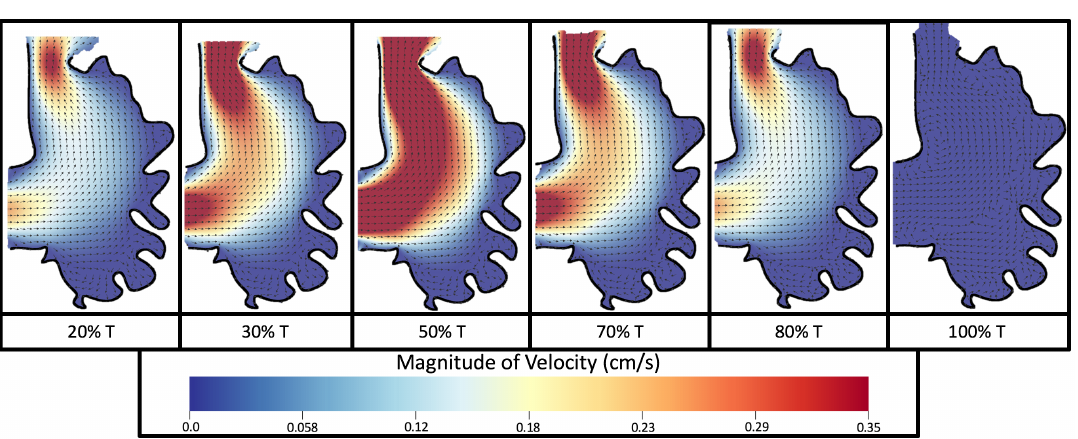
Figure 8. Temporal snapshots of the flow at different points during a pulsation cycle, described by a percentage of the pulsation period, T , for the 5 dpf (I) WT ventricle at Re = 1. The magnitude of velocity (cm/s) is given by the colormap and the direction of flow is given by the arrows.